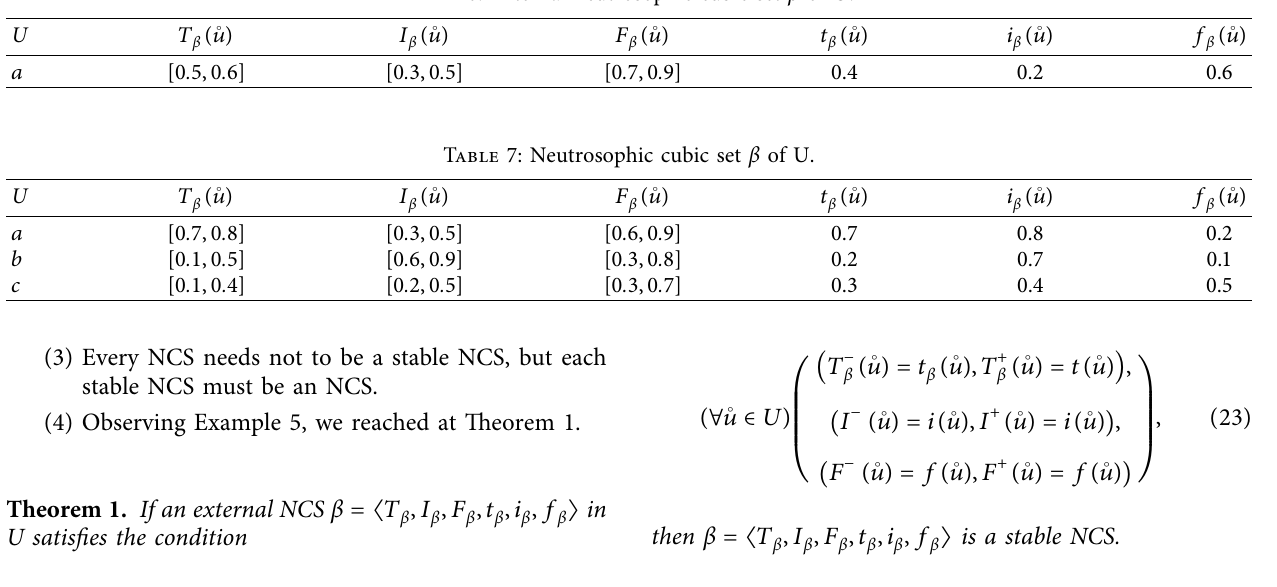
Table 6: External neutrosophic cubic set β of U.